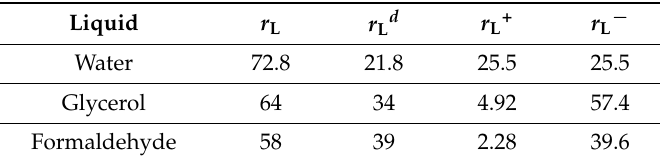
Table 4. The surface energy parameters of liquids (mJ/m)